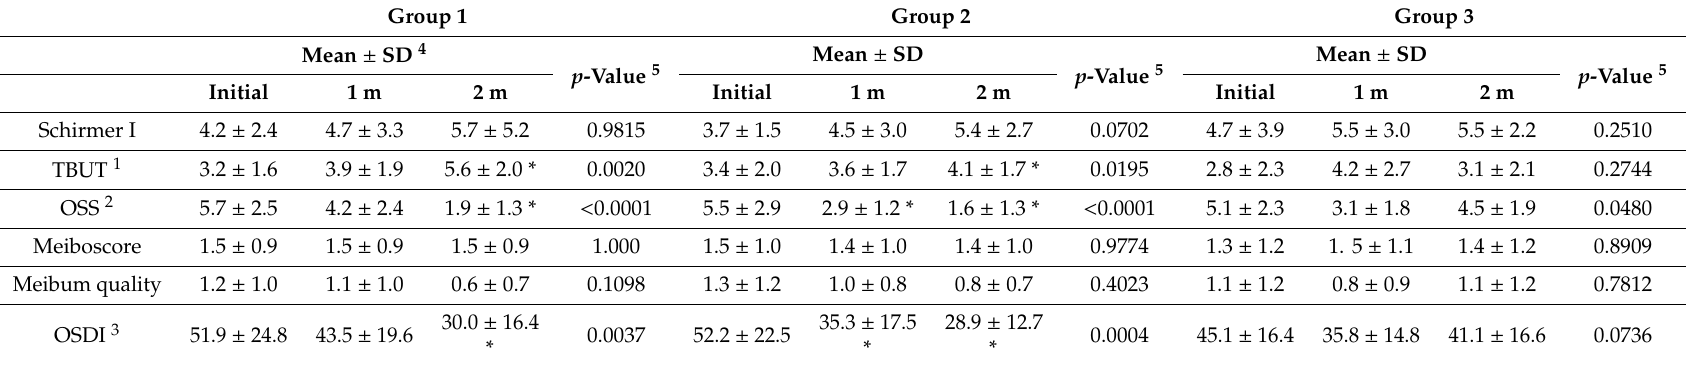
Table 2. Change of ocular surface parameters after treatment in each